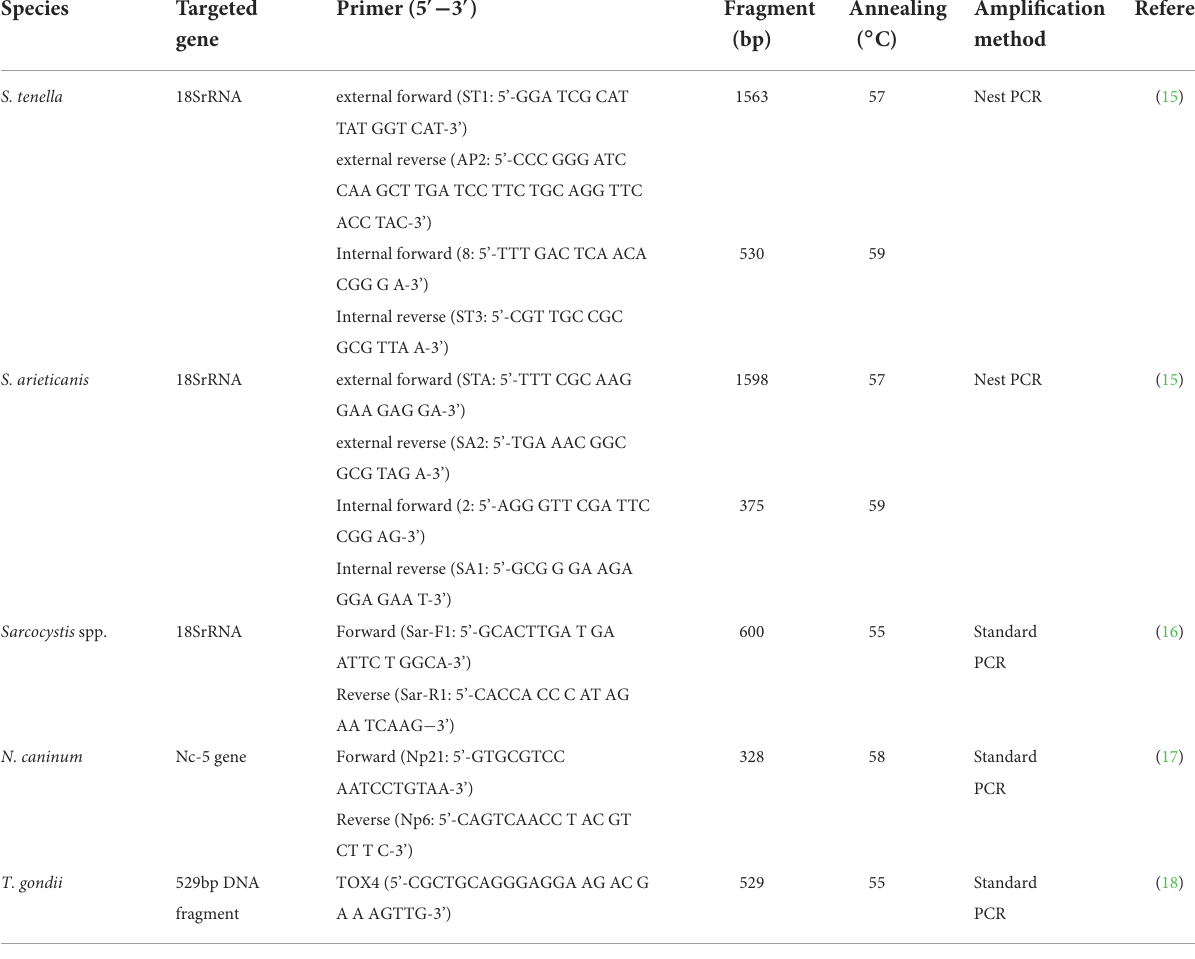
TABLE 1 Information of the primers used in PCR detection of the three species of parasites. Species